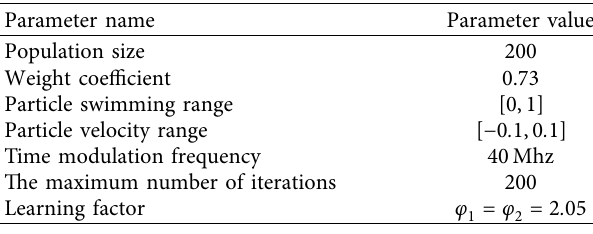
Table 2: PSO algorithm parameter initialization.